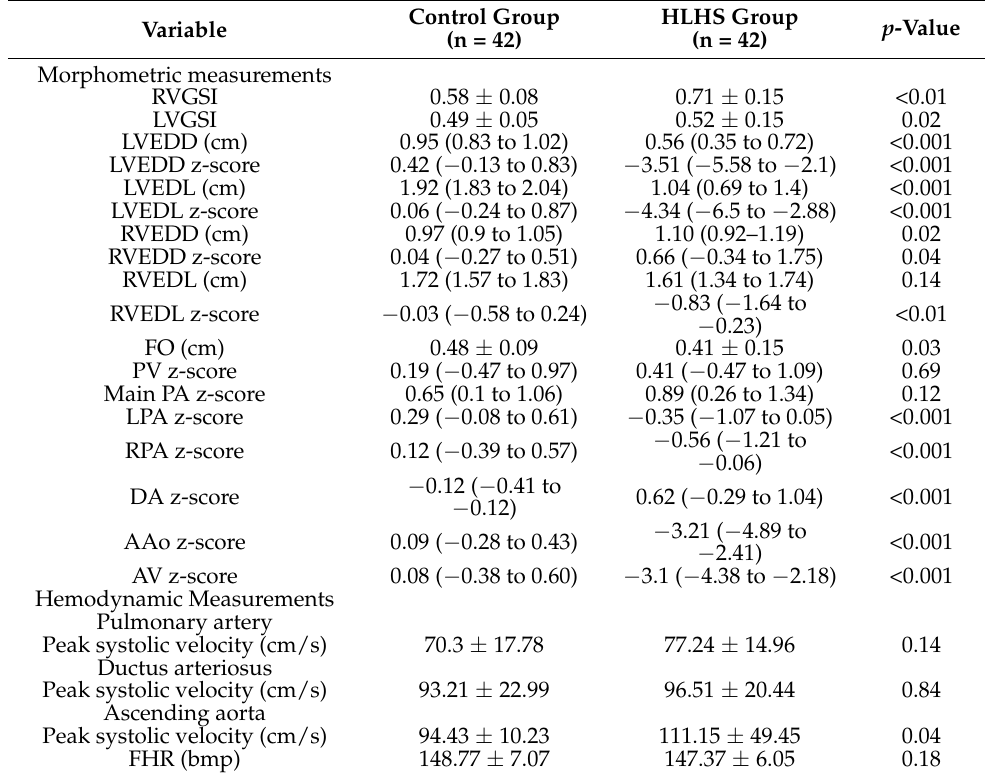
Table 2. Fetal left and right heart dimensions and hemodynamics in HLHS fetuses and normal fetuses at 23~30 gestational weeks.